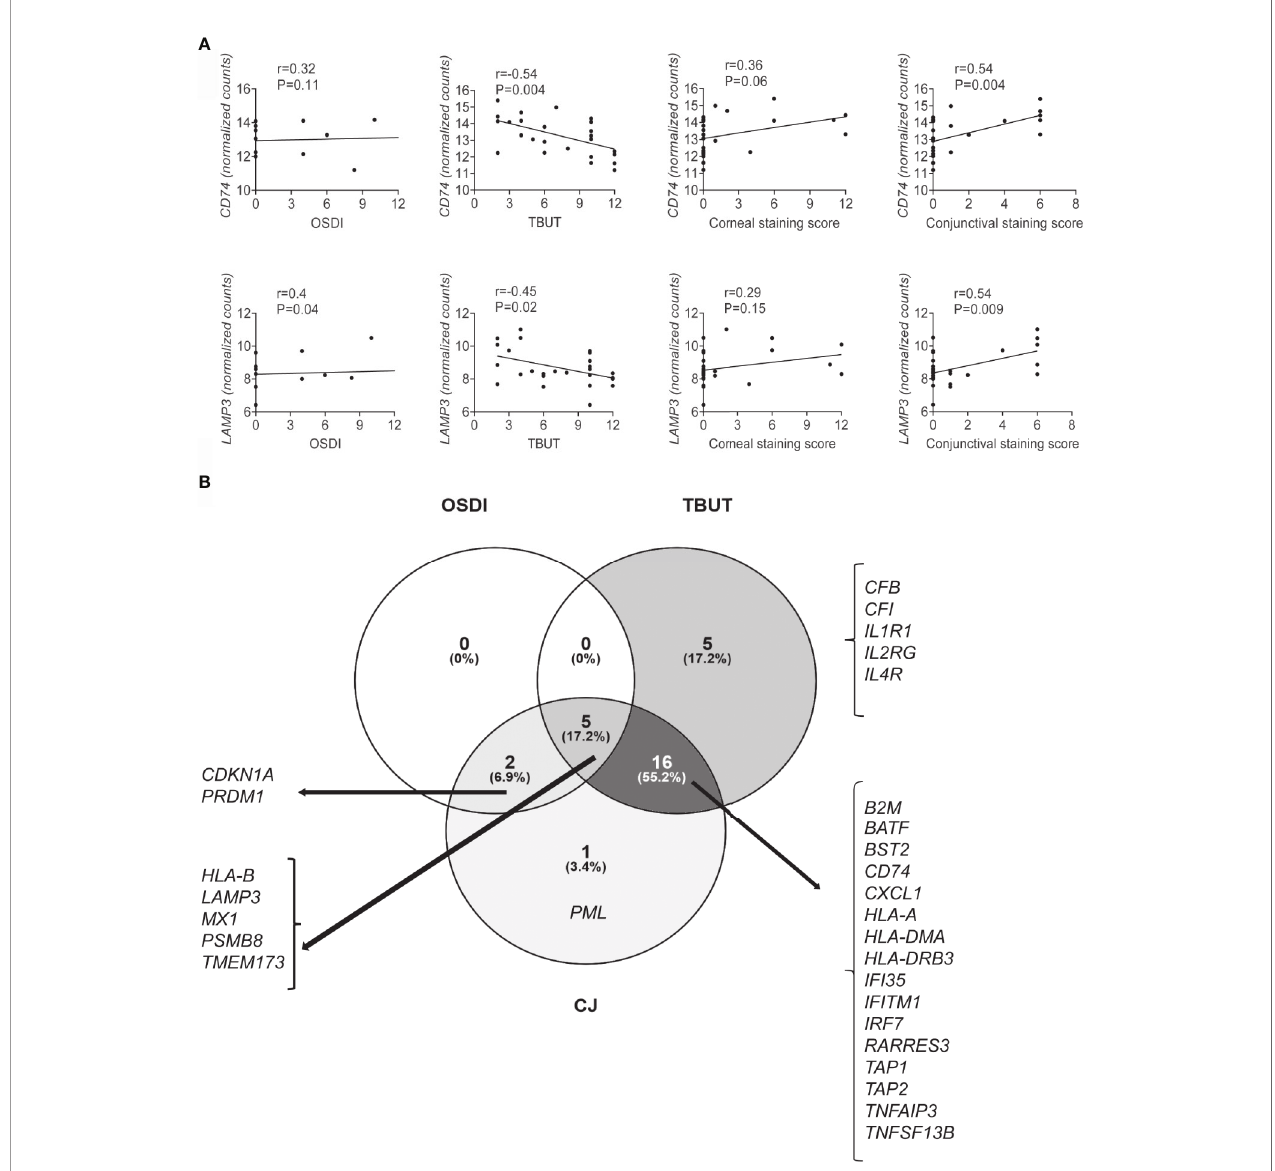
FIGURE 5 | A subset of upregulated genes correlates with ocular symptoms and signs. Spearman correlations of clinical symptoms (OSDI), Tear-break-up time (TBUT), and conjunctival (CJ) staining score with up or downregulated DEGs were calculated using GraphPad Prism software using clinical data from all subjects (19 healthy controls and 7 SS KCS subjects). (A) Representative graph showing Spearman correlations of CD74 and LAMP3 vs. OSDI, TBUT, corneal staining score, and conjunctival staining score. Additional genes are shown in Table 3 . (B) Venn diagram showing common and unique correlation of genes and OSDI, TBUT, and conjunctival staining score. R = coef fi cient of correlation. Please note that GraphPad Prism does not plot all dots if they